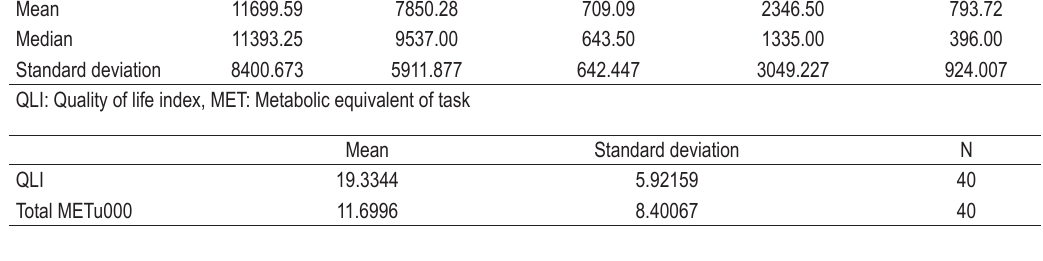
TABLE 13. Significance of the regression model coefficients Model